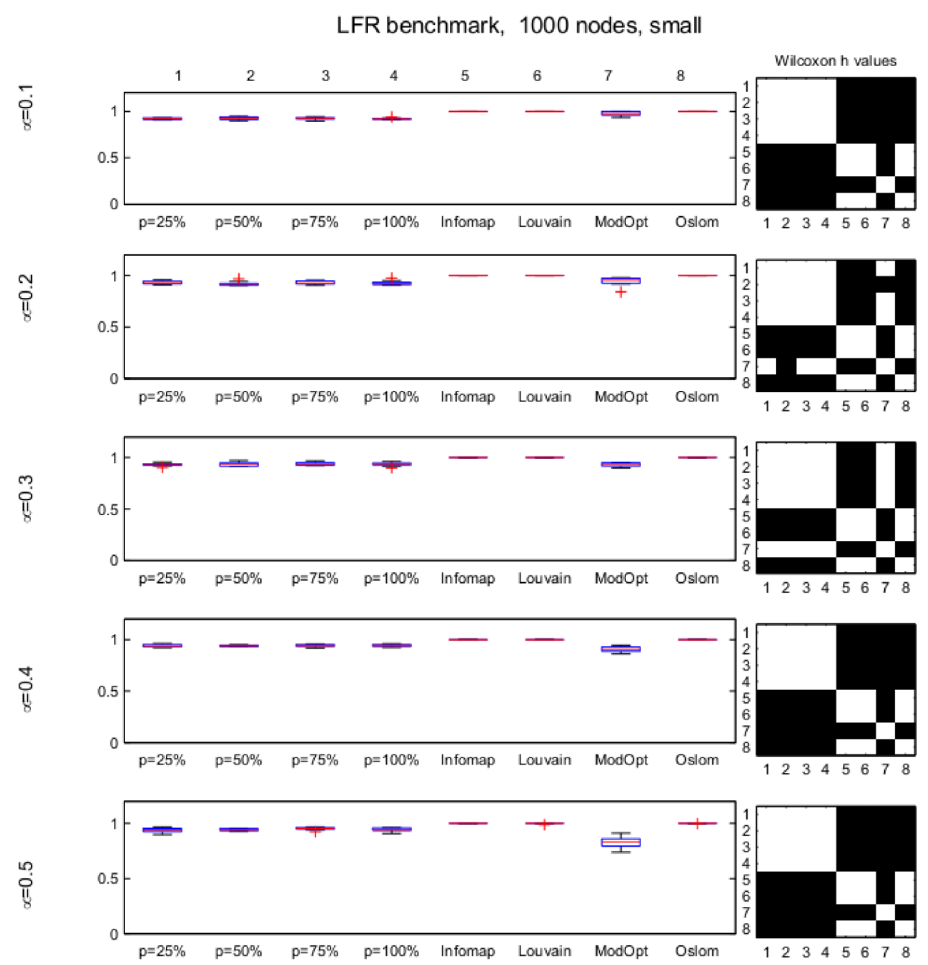
Fig 7. LFR small, 1000 nodes; boxplots of NMI values for all methods considered (left). On the right, the black-white matrix represents Wilcoxon h values for each pair of methods considered, numbered in the order they appearin the boxplot. A black squareindicates a statistical difference